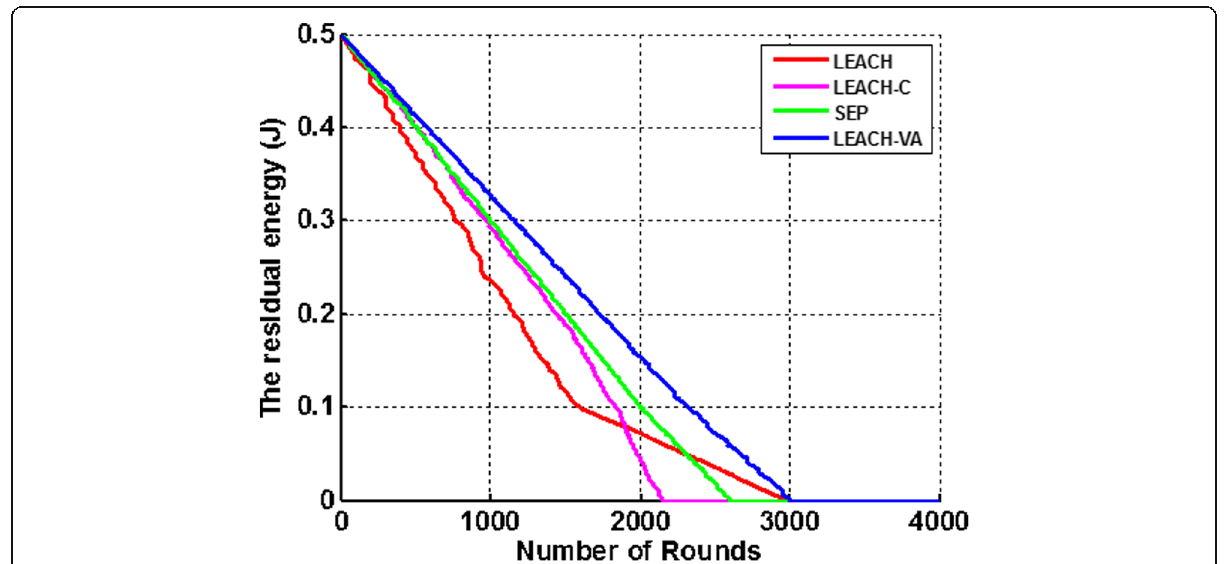
Fig. 8 Round versus the number of residual